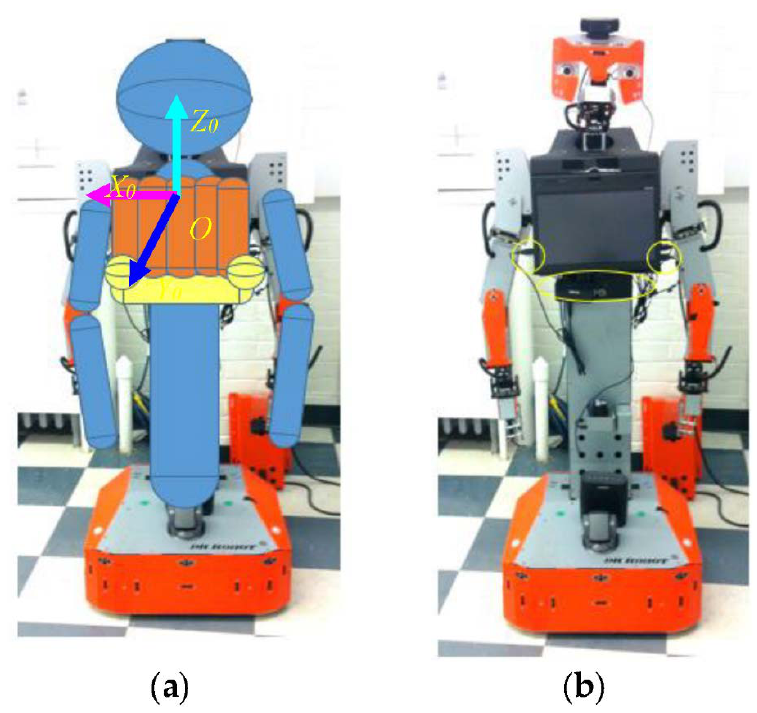
Figure 8. ( a ) The Tangy robot; ( b ) modeled with three spheres and eleven capsules.